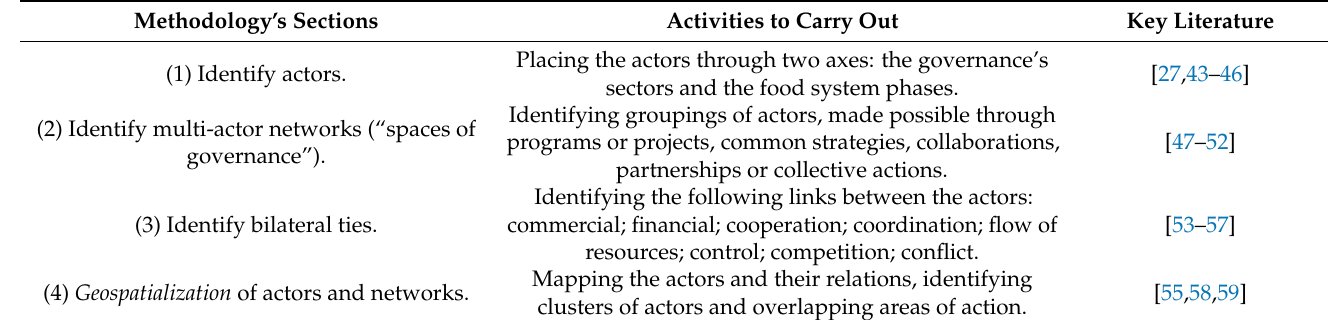
Table 1. The operational construction of the methodology and the key literature (authors’ elaborations).